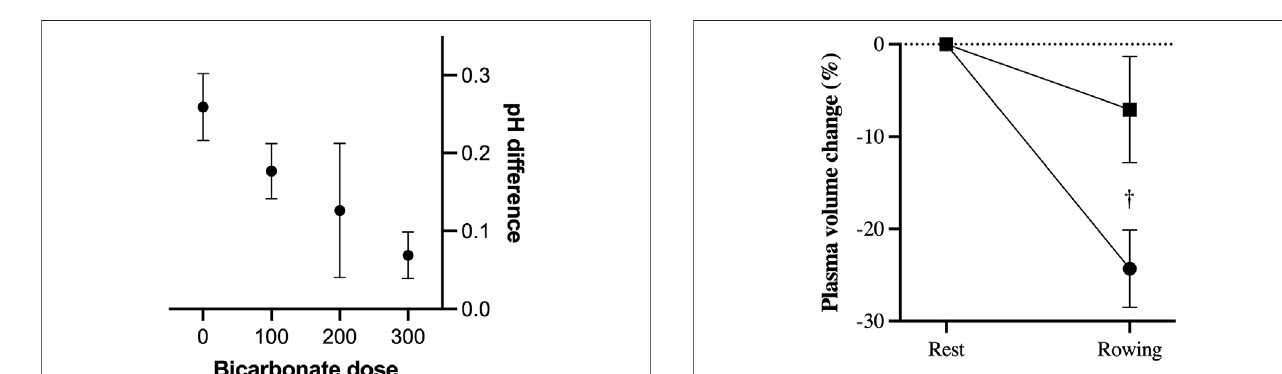
FIGURE 1 | pH effect of different doses of bicarbonate administered intravenosly during maximal ergometer rowing in seven oarsmen. X -axis is the dose group of bicarbonate used (100: use of 100 mmol in two subjects, 200 use of 200 – 240 mmol in four subjects and 300 administration of 300 – 340 mmolinfoursubjects)while “ 0 ” representthecontrolsalinetrialinsix subjects. Y -axisisthedifferencebetweenthepHatrestinsamplesobtainedin the sixth minute of rowing. It is a limitation not all subjects received same amount of bicarbonate.